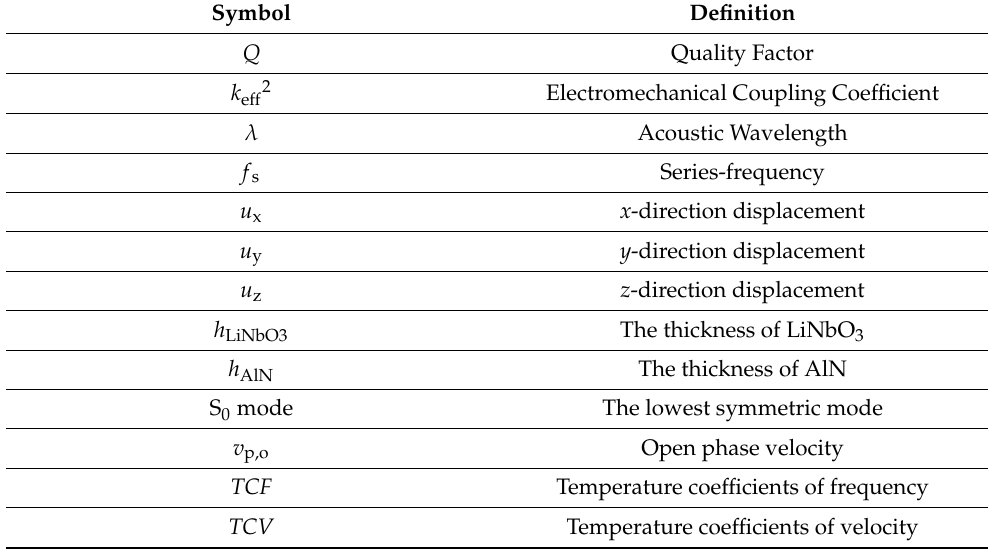
Table 1. Symbols used in this